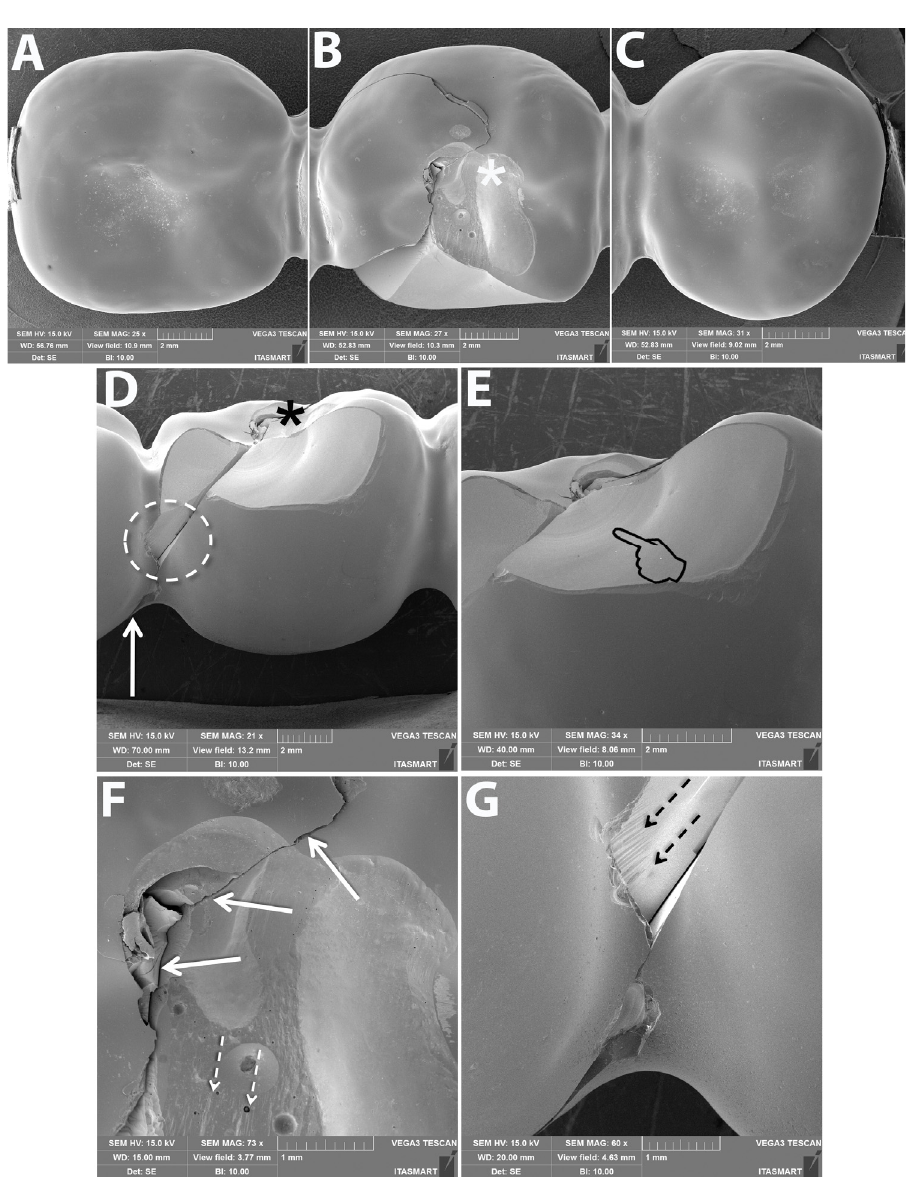
Figure 6. Representative scanning electron microscopy (SEM) micrographs of fractured monolithic FDP from Group Z-HT. Occlusal overviews of abutments ( A , C ) show intact marginal ridges and connectors whereas the pontic ( B ) presents a cohesive fracture at the occlusal (asterisk) and buccal surfaces, as well as a crack that extends towards the distal abutment. ( D ) Buccal overview shows loading area at the occlusal surface where the fracture seems to have originated (asterisk) and a crack that extends down to the gingival part of the connector. In a magnification view of the cohesive surface fracture at the buccal surface ( E ) arrest lines (pointer) with their concave portion pointing towards the occlusal surface indicate the fracture origin. ( F ) is a magnification of the occlusal surface where the solid arrows show a crack initiating at the occlusal and propagating down towards the gingival portion of the connector and the other crack front showing its direction towards the buccal surface, eventually leading to the cohesive fracture at the buccal surface (suggested by the hackle lines pointed by the dotted arrows). ( G ) is a magnification of the area circled in D where the main buccal cohesive fracture ended at the mesial portion of the FDP distal abutment showing hackle lines (dotted arrows) indicating the direction of crack propagation.